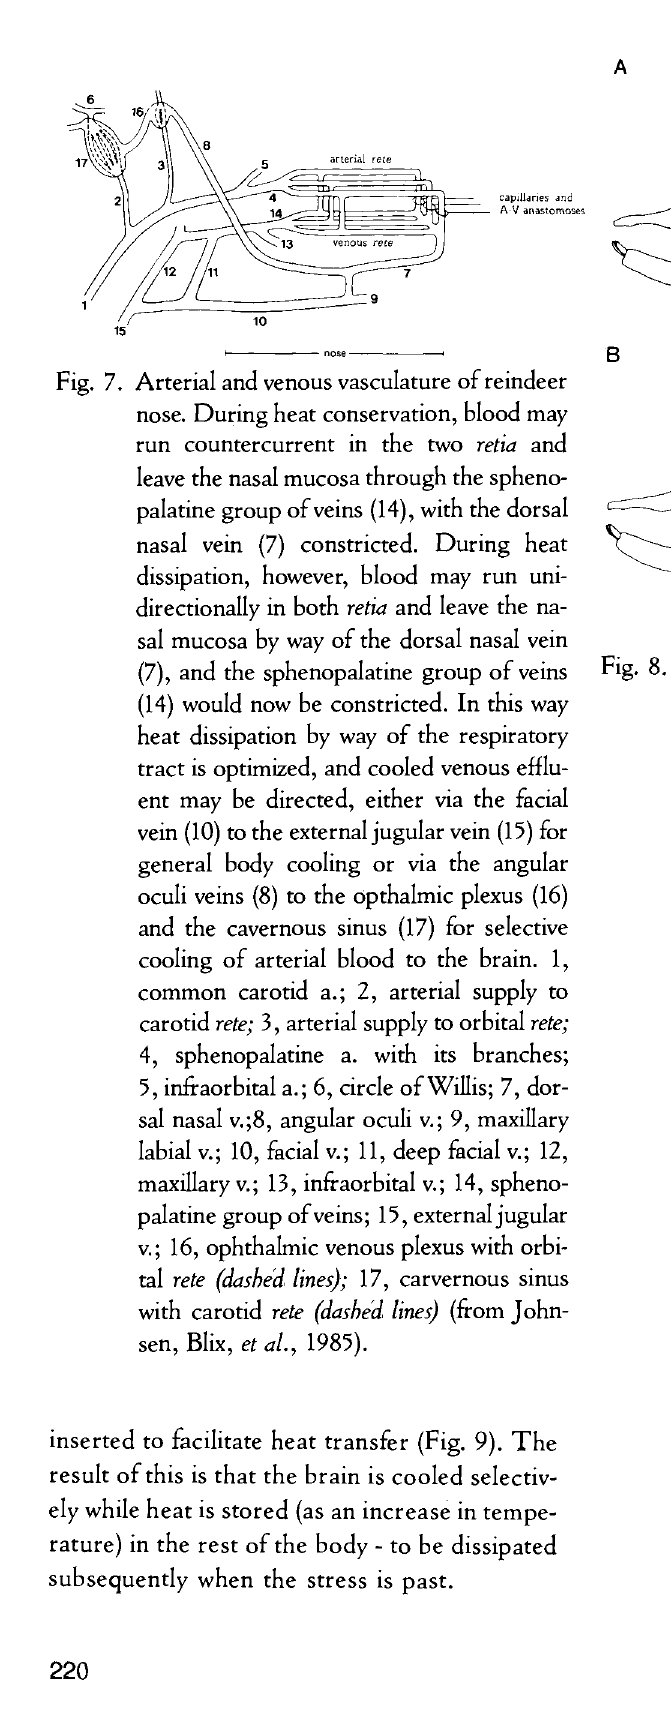
Fig. 8. Schematic diagram of superficial veins of nose and their connections with the caver nous sinus at the base of the brain in rela tion to the outline of the skull in